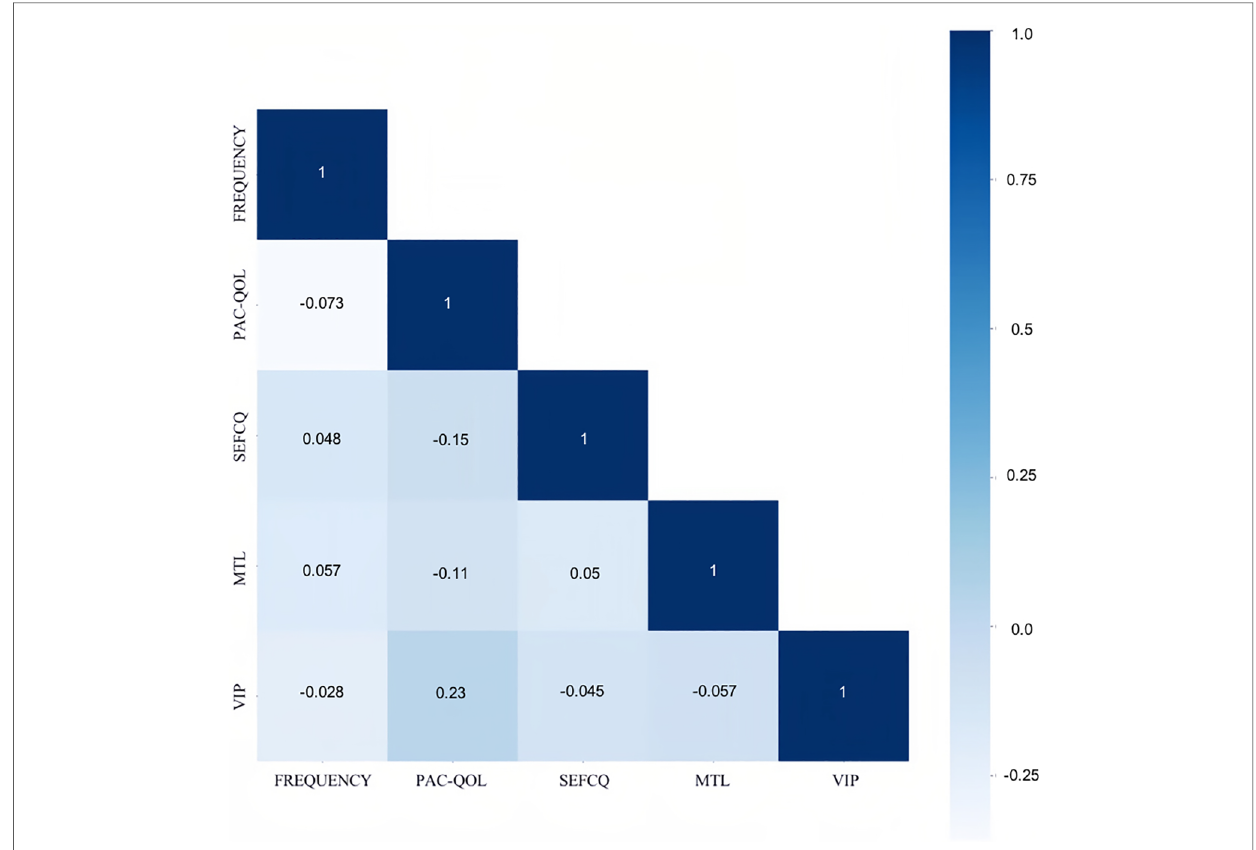
FIGURE 3 The correlation of the best variables through the heat map. The Spearman correlation was used for this heat map matrix of the top 5 variables as identi fi ed by SelectKBest. Each variable on the heat map has a correlation coef fi cient represented by the color gradient scale. The more positively correlated the features are the darker the shades of blue. FREQUENCY, stool frequency; PAC-QOL, PAC-QOL (Satisfaction); SEFCQ, SEFCQ (Emotion); MTL, motilin; VIP, vasoactive intestinal peptide.